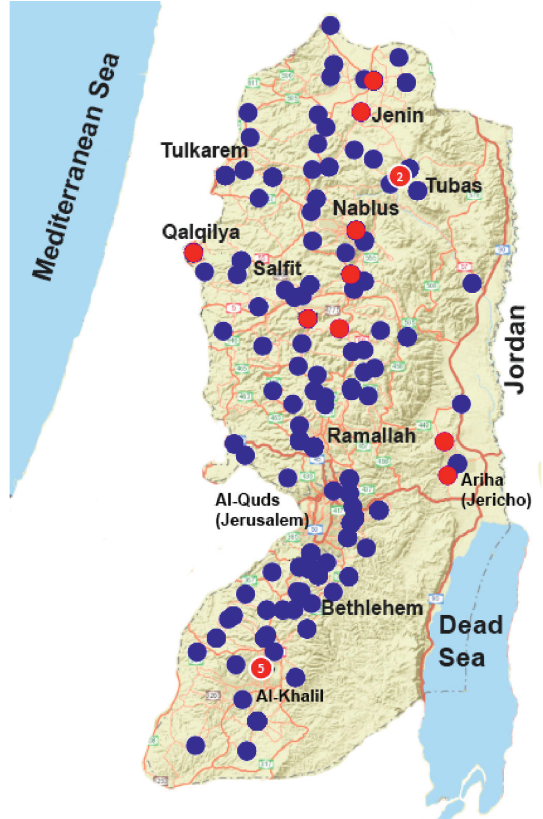
Figure 1: Spot map of the 16 HEV-IgG positive cases (red). The blue circles represent study participants from the 11 Palestinian districts. The numbers in the red circles represent the number of HEV-IgG positive samples in that geographical